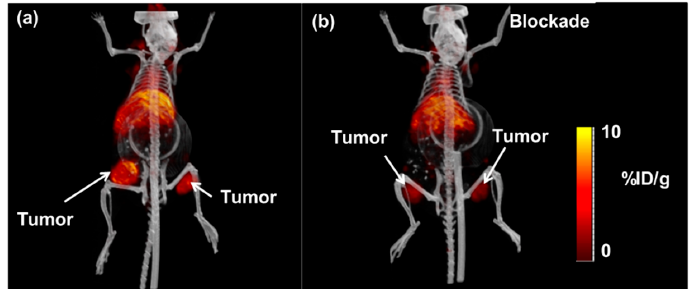
Figure 4. ( a ) Whole body volume rendered PET/CT image (72 h p.i.) of an animal receiving [ 89 Zr]Zr-Df-Bz-F19, showing tumor retention of the radiotracer; ( b ) whole body volume rendered PET/CT image (72 h p.i.) of an animal receiving [ 89 Zr]Zr-Df-Bz-F19 and F19 mAb blockade. Radioactivity within tumors is significantly reduced upon blockade. Arrows indicate position of tumor.